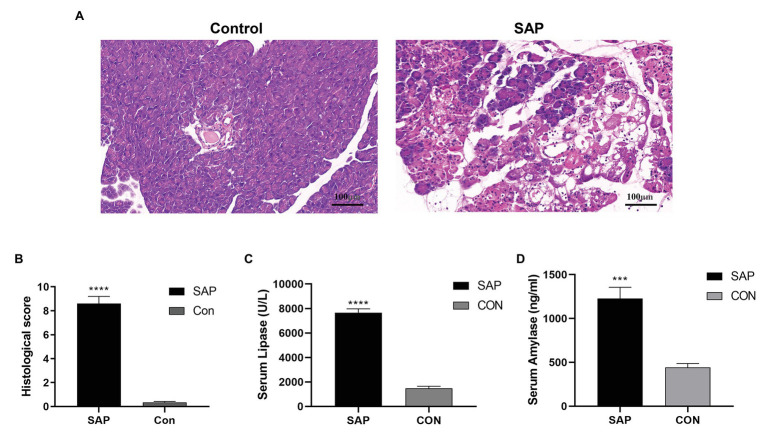
Evaluation of the SAP Model. (A) Compared with the control group (con), the histopathological sections of the pancreas in the SAP group showed focal expansion of the interlobular space of the pancreas, edema of the pancreatic lobules, extensive acinar cell necrosis and granulocyte infiltration (100x). (B) The histological score of pancreatic tissue. (C,D) The lipase and amylase levels were also significantly higher than the control group (p < 0.05). ***p < 0.001, vs. control group, n = 3 per group.